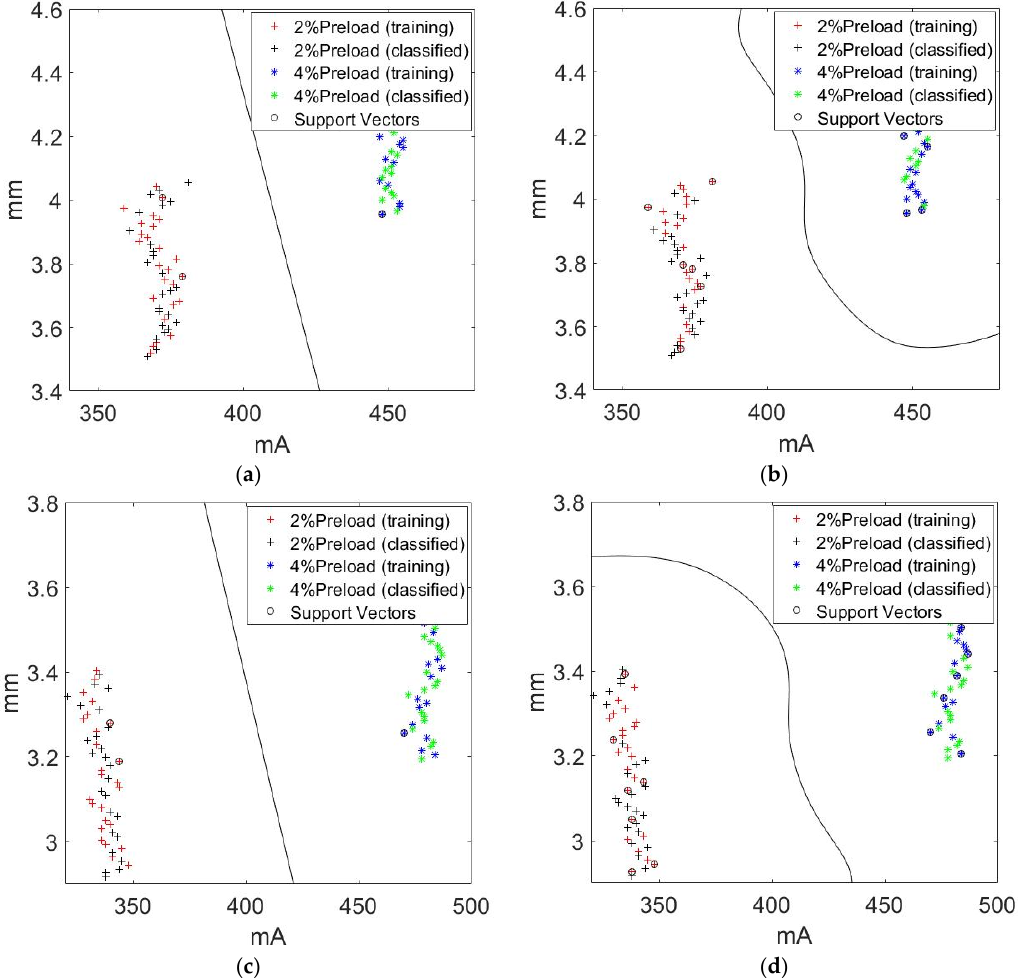
Figure 6. 100% classification rate results for the 2% and 4% ball-nut preloads based on the current and linear scale signals without oil-cooling circulation with the ( a ) linear SVM kernel function, ( b ) radial kernel function, ( c ) linear SVM kernel function with an additional pretension of 5 μ, and ( d ) radial kernel function with an additional pretension of 5 μ.